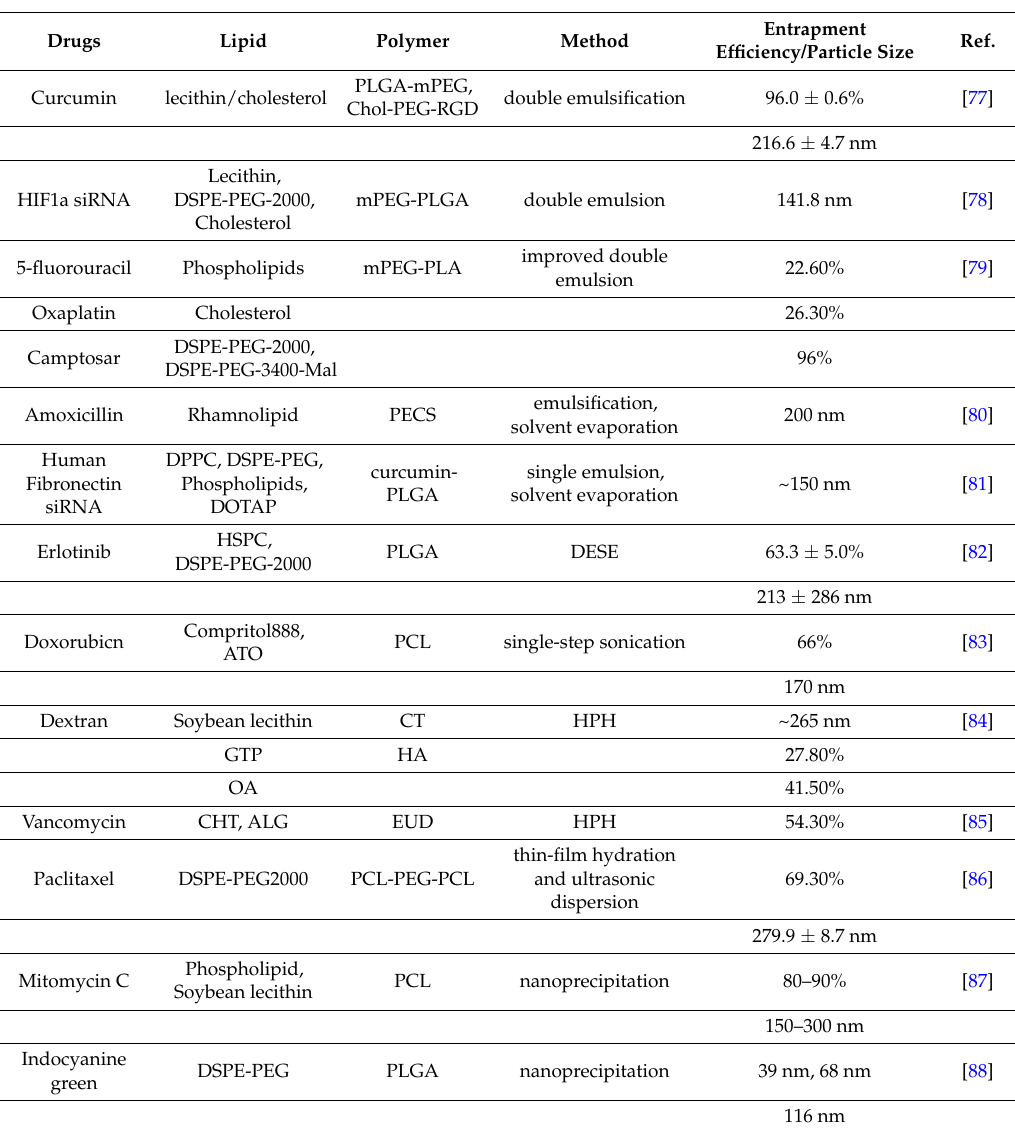
Table 3. Summary of methods used to prepare